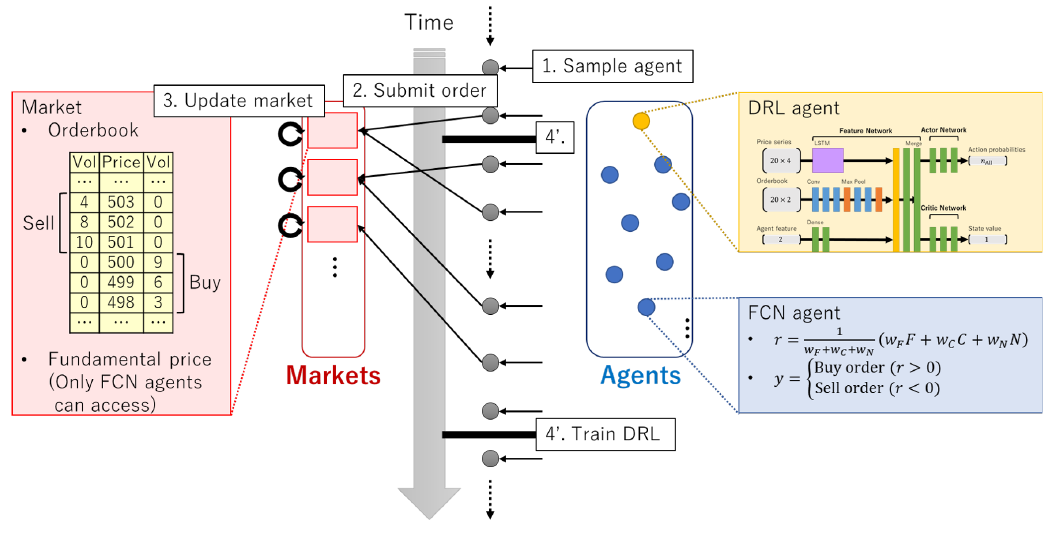
Figure 1. Overview of the simulation framework proposed in this research. The simulator consists of markets and agents where markets play the role of the environment whose state evolves through the actions of the agents. There are two types of agents—deep reinforcement learning (DRL) agent and fundamental-chart-noise (FCN) agents. The objective of the agents is to maximize their capital amount. In each step of simulation, an agent to submit an order is sampled, the agent submits an order, and markets process orders and update their orderbooks. The DRL model in the DRL agent is trained in a certain time